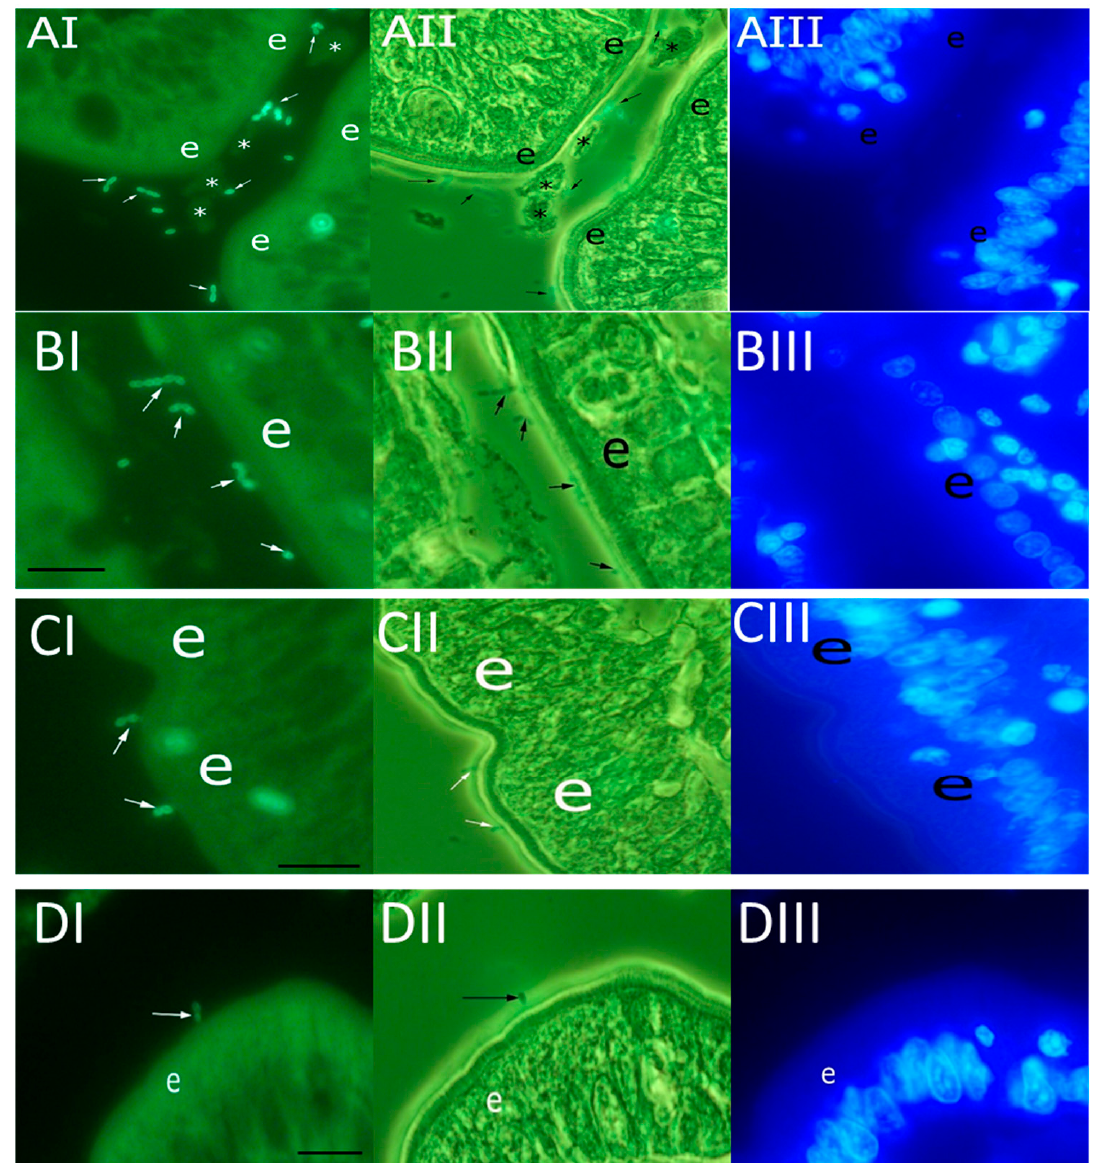
Figure 1. Adherence of AF488-stained E. faecalis and E. faecium to paraffin-embedded sections of the duodenal mucosa of beagle dogs. The bacterial strains shown are ( A ) canine E. faecalis O-67; ( B ) chicken E. faecalis EF368/1; ( C ) canine E. faecium EF397/1; and ( D ) chicken E. faecium EF369/9. Epifluorescence (I), epifluorescence and phase contrast combination (II), and DAPI-stained (III) images are shown. Arrows indicate bacteria adhered to the epithelium and the symbol “e” indicates the epithelial layer of the duodenal mucosa. Asterisks (*) indicate mucus. Scale bars, 50 µm.